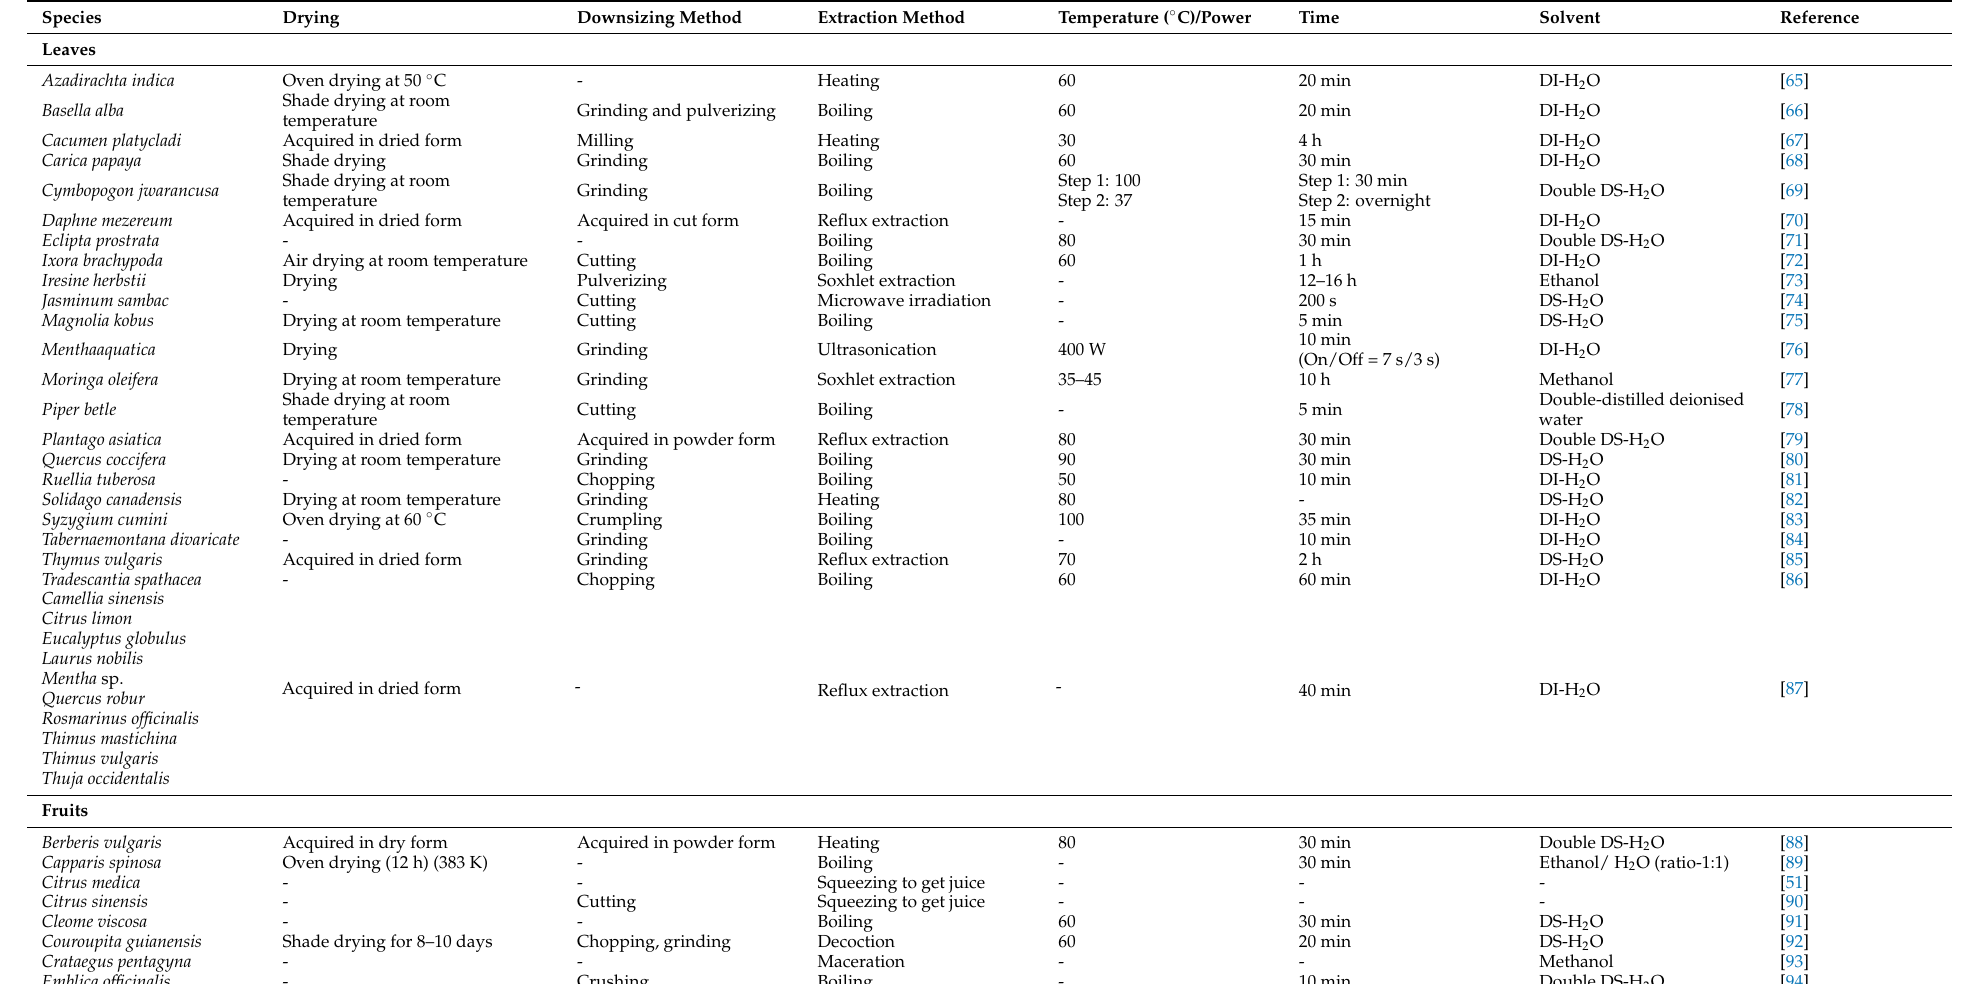
Table 1. Parameters and extraction method utilised for extraction of different plant